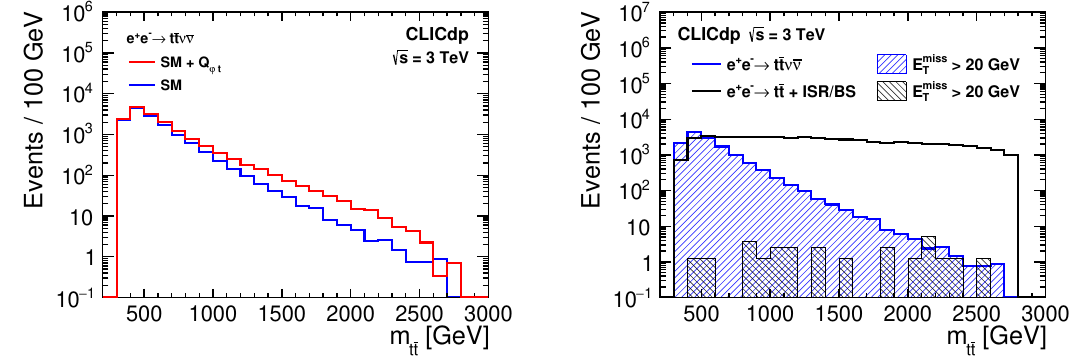
p Figure 24. Top-quark pair invariant mass distributions for CLIC at s = 3 TeV with 5 ab (cid:0) 1 . e + e (cid:0) ! tt nn (VBF) after a cut on the invariant mass of the two neutrinos, illustrating the e(cid:11)ect of including one example EFT operator, Q , that grows with energy (left). VBF signal distribution ’ t and the e + e (cid:0) ! tt SM background process before and after a cut on the total missing transverse energy, E miss > 20 GeV (right). Note that e + e (cid:0) ! tt includes both ISR and beamstrahlung (BS) T